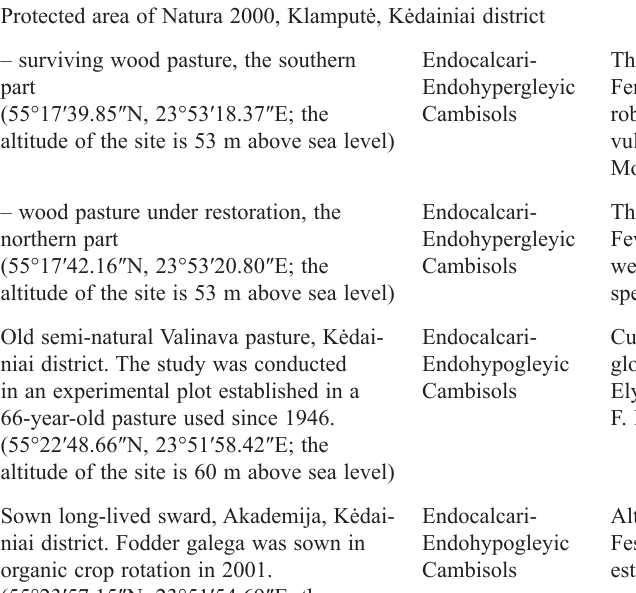
Table 1. Site characteristics, Central Lithuania, 2012 site soil Vegetation